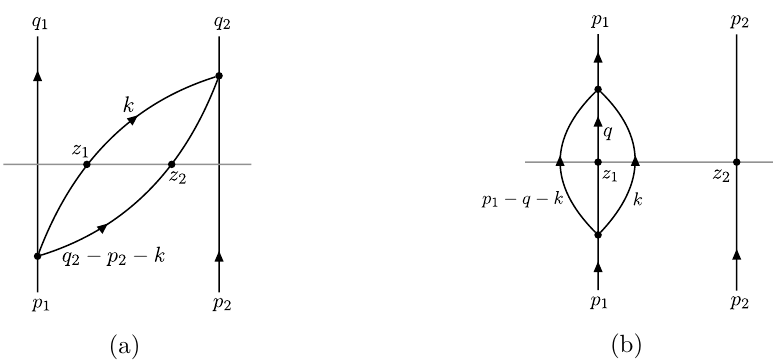
Figure 17. Loop-level contributions to the mixing of H ( z 1 , z 2 ) . (a) Connected diagram which induces “smearing” on celestial sphere. (b) Disconnected diagram for the correction to an individual detector. There exist other diagrams at O ( λ ) and O ( λ 2 ) but they do not contain IR